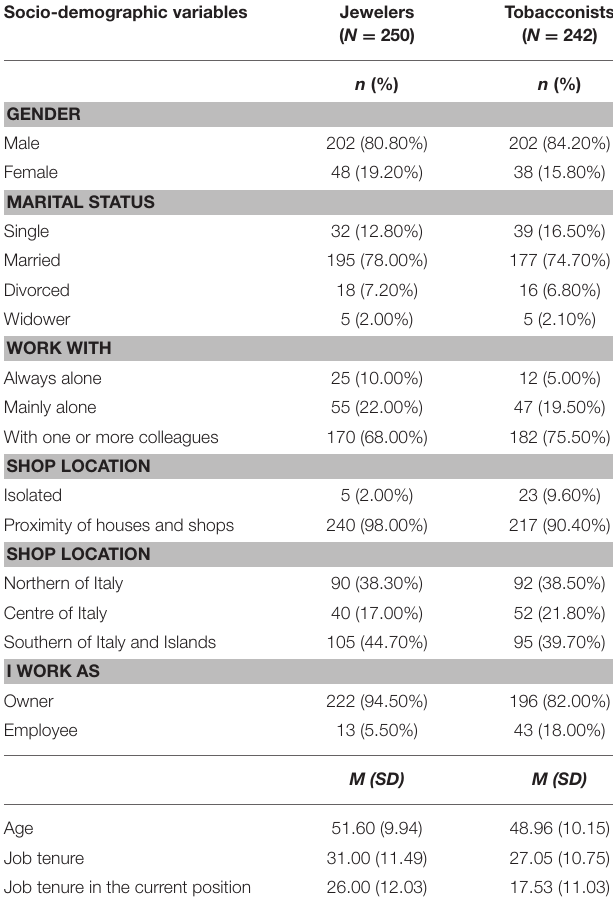
TABLE 1 | Socio-demographic data compared for professional